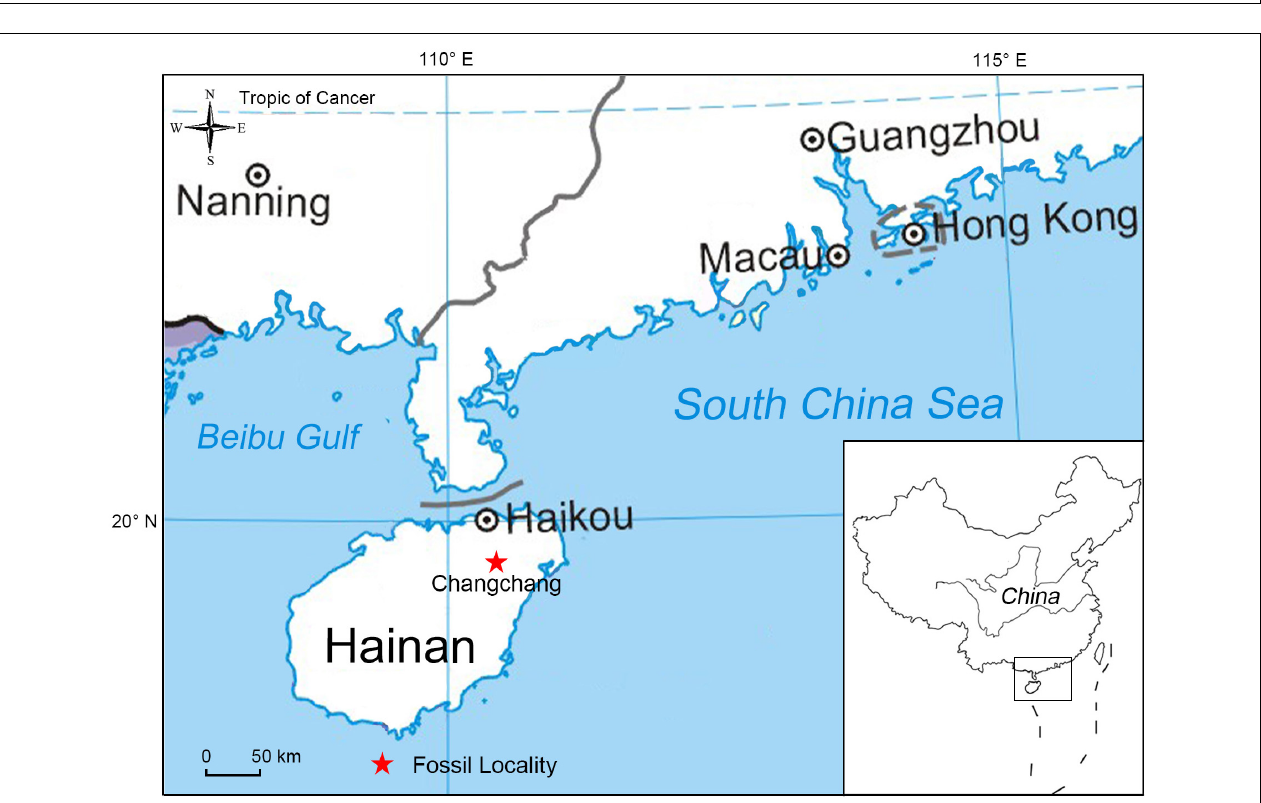
FIGURE 2 | Geographic map of the fossil locality. Base map modified after the Standard Map Service of the National Administration of Surveying, Mapping and Geoinformation of China